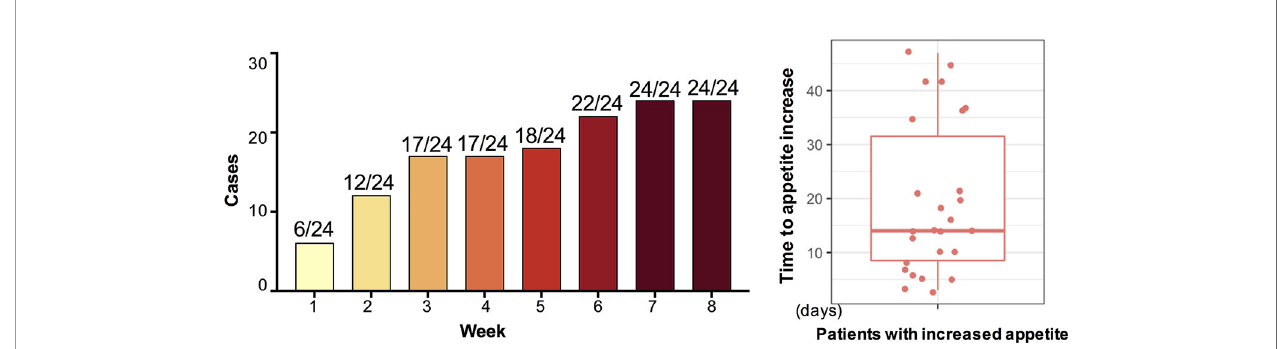
FIGURE 1 | Number of patients with increased appetite during 8-week olanzapine treatment